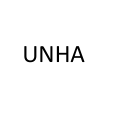
Figura 1 . Item de codi fi cação do teste de reconhecimento individual.